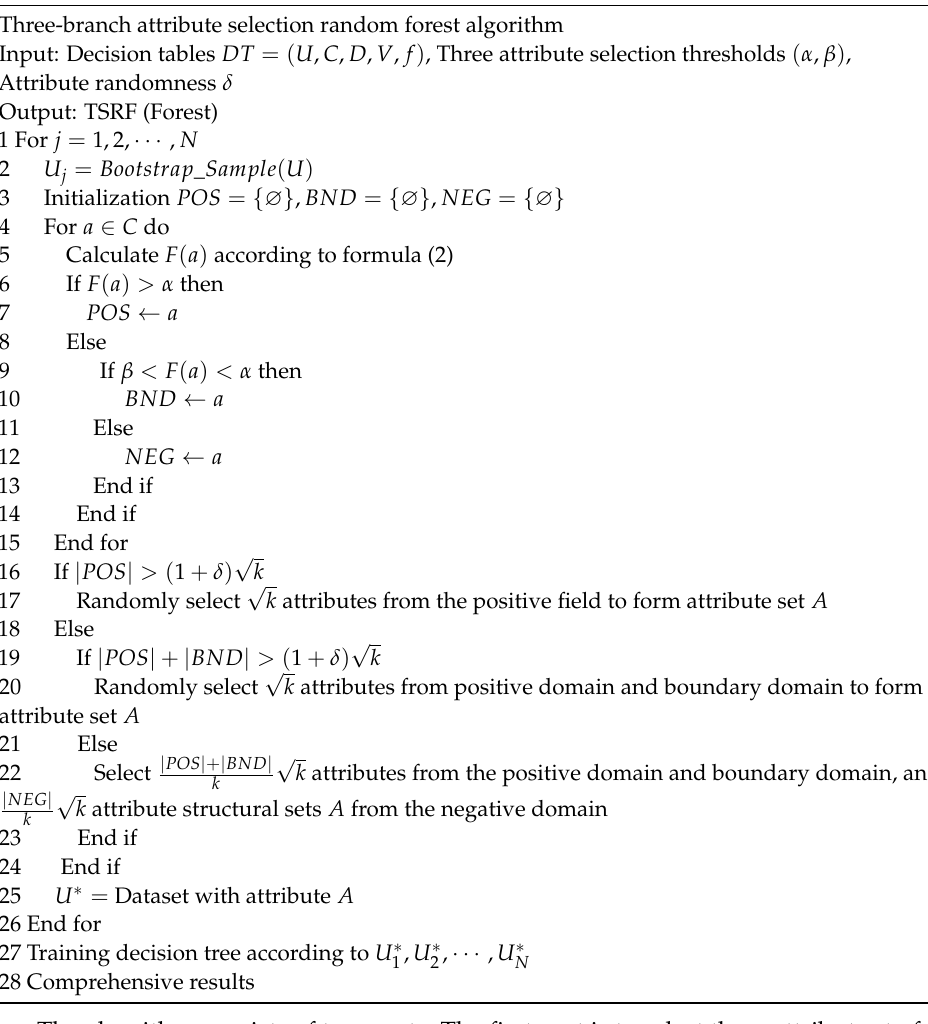
Algorithm 1: Three-branch attribute selection random forest algorithm Three-branch attribute selection random forest